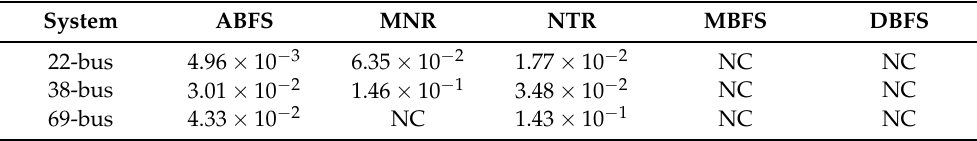
Table 6. Computation time required to solve power flow for case22, case38, and case69 considering the ABFS, MNR, NTR, MBFS, and DBFS algorithms. (NC: not